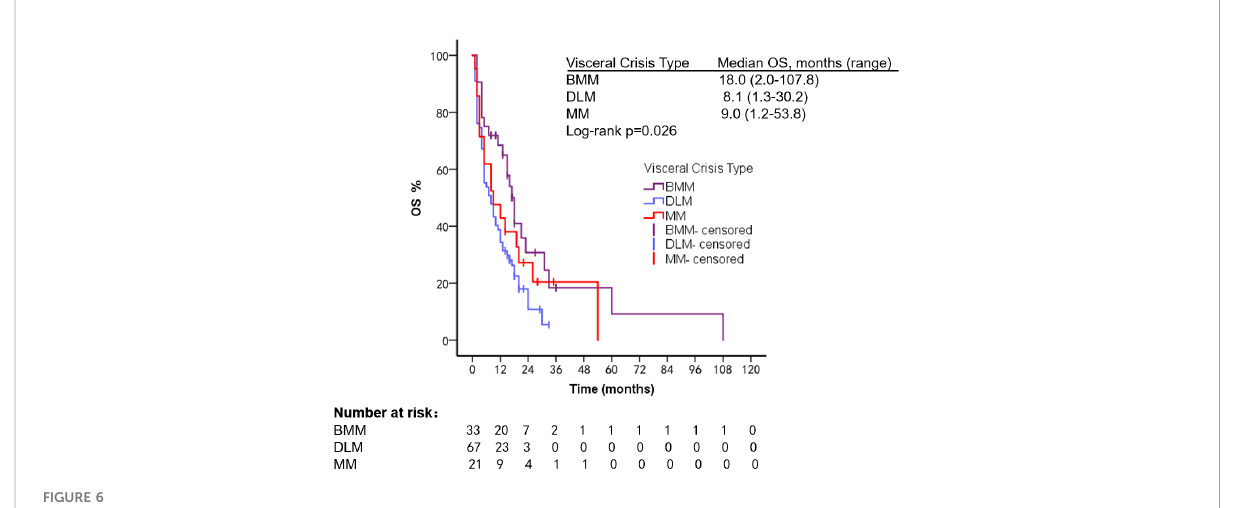
FIGURE 6 OS of patients with HR+, Her-2 − type using different treatment regimens.